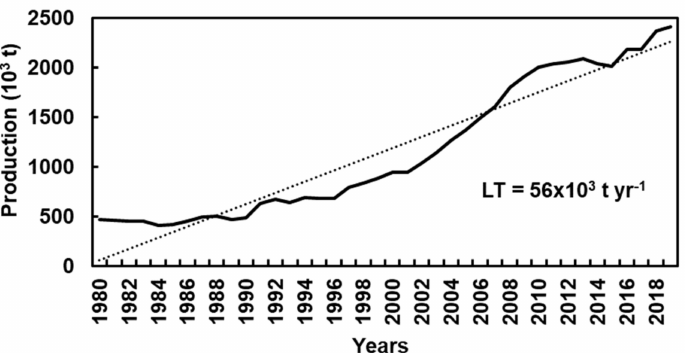
Figure 1. Chestnut production in the world, between 1980 and 2019 [14].